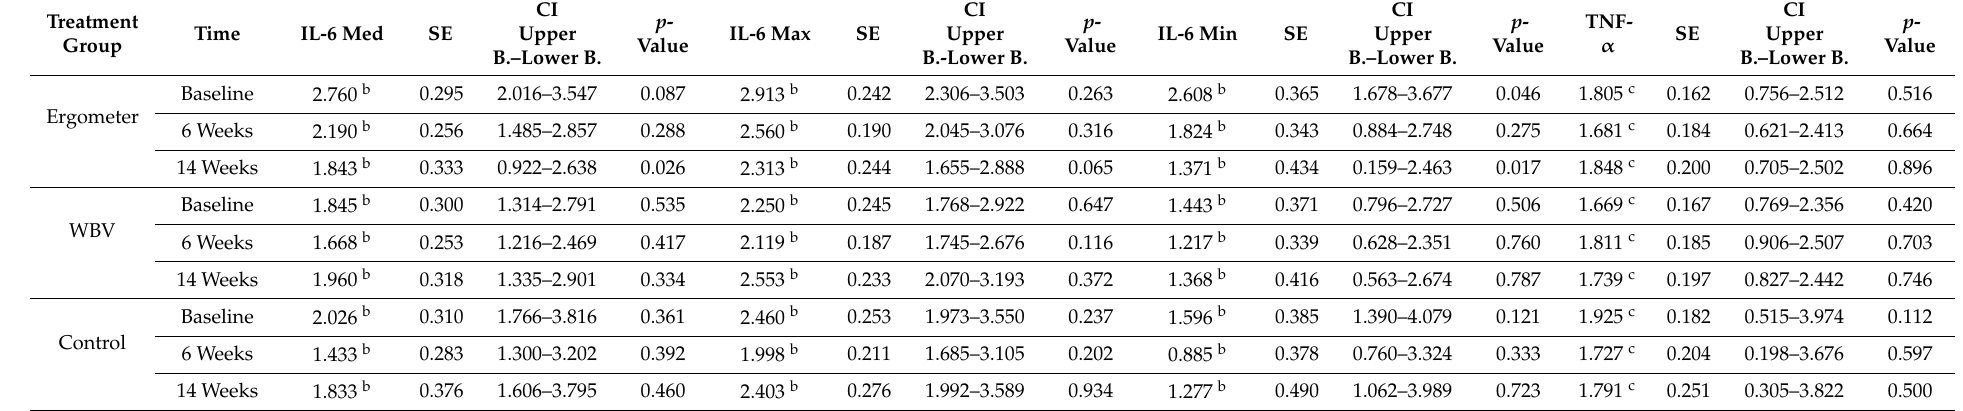
Table 3. Means and standard error (SE) of IL-6 and TNF- α for all treatment groups over time, estimates of mixed model